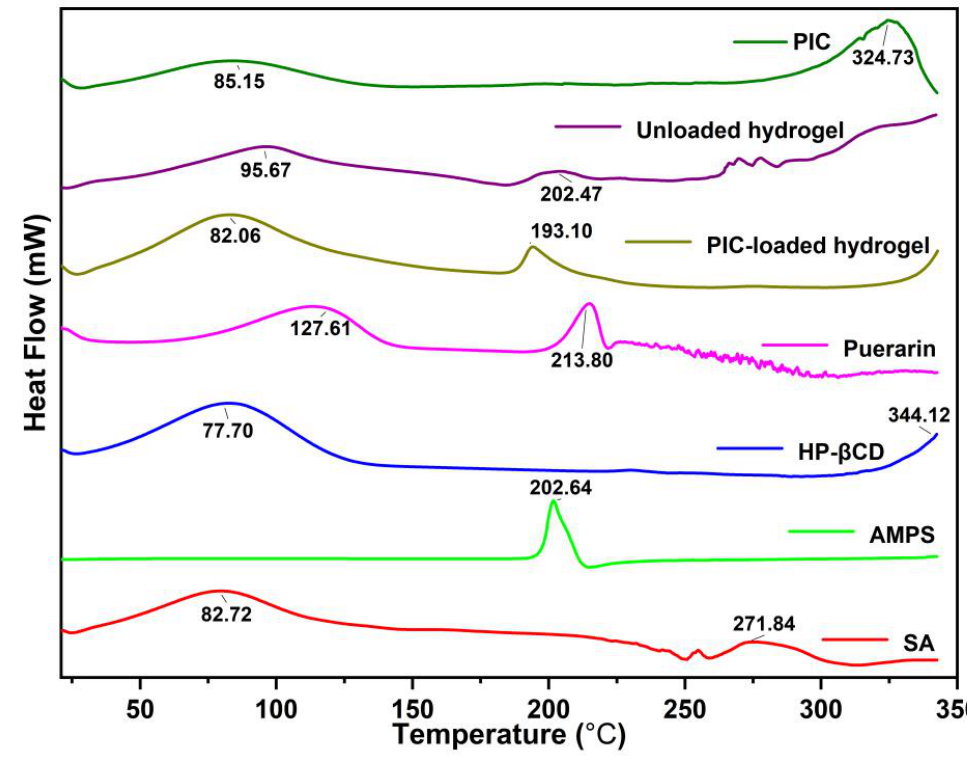
Figure 3. The DSC of puerarin, HP-βCD, SA, PIC , AMPS, unloaded, and PIC -loaded